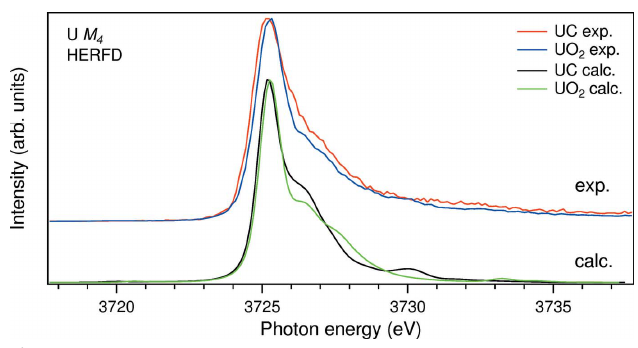
Figure 3 Calculated and measured U M 4 HERFD-XAS spectra of UC and UO 2